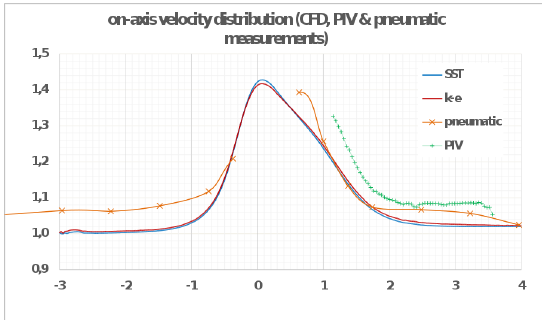
Table 2: Mesh parameters.